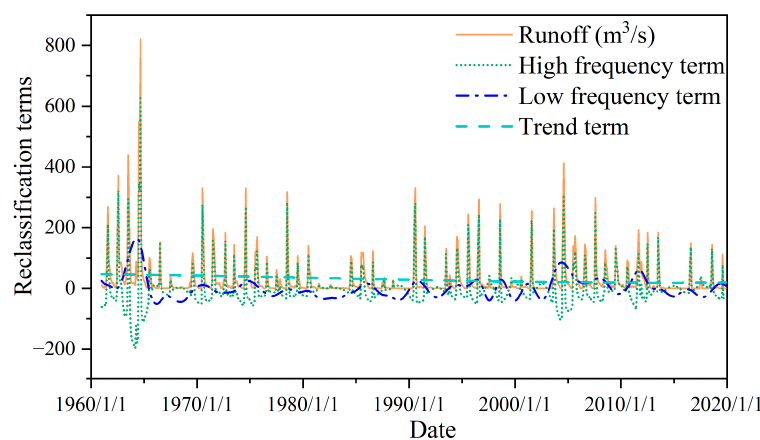
Figure 21. The reclassified IMF terms and original runoff data for Daicunba station.